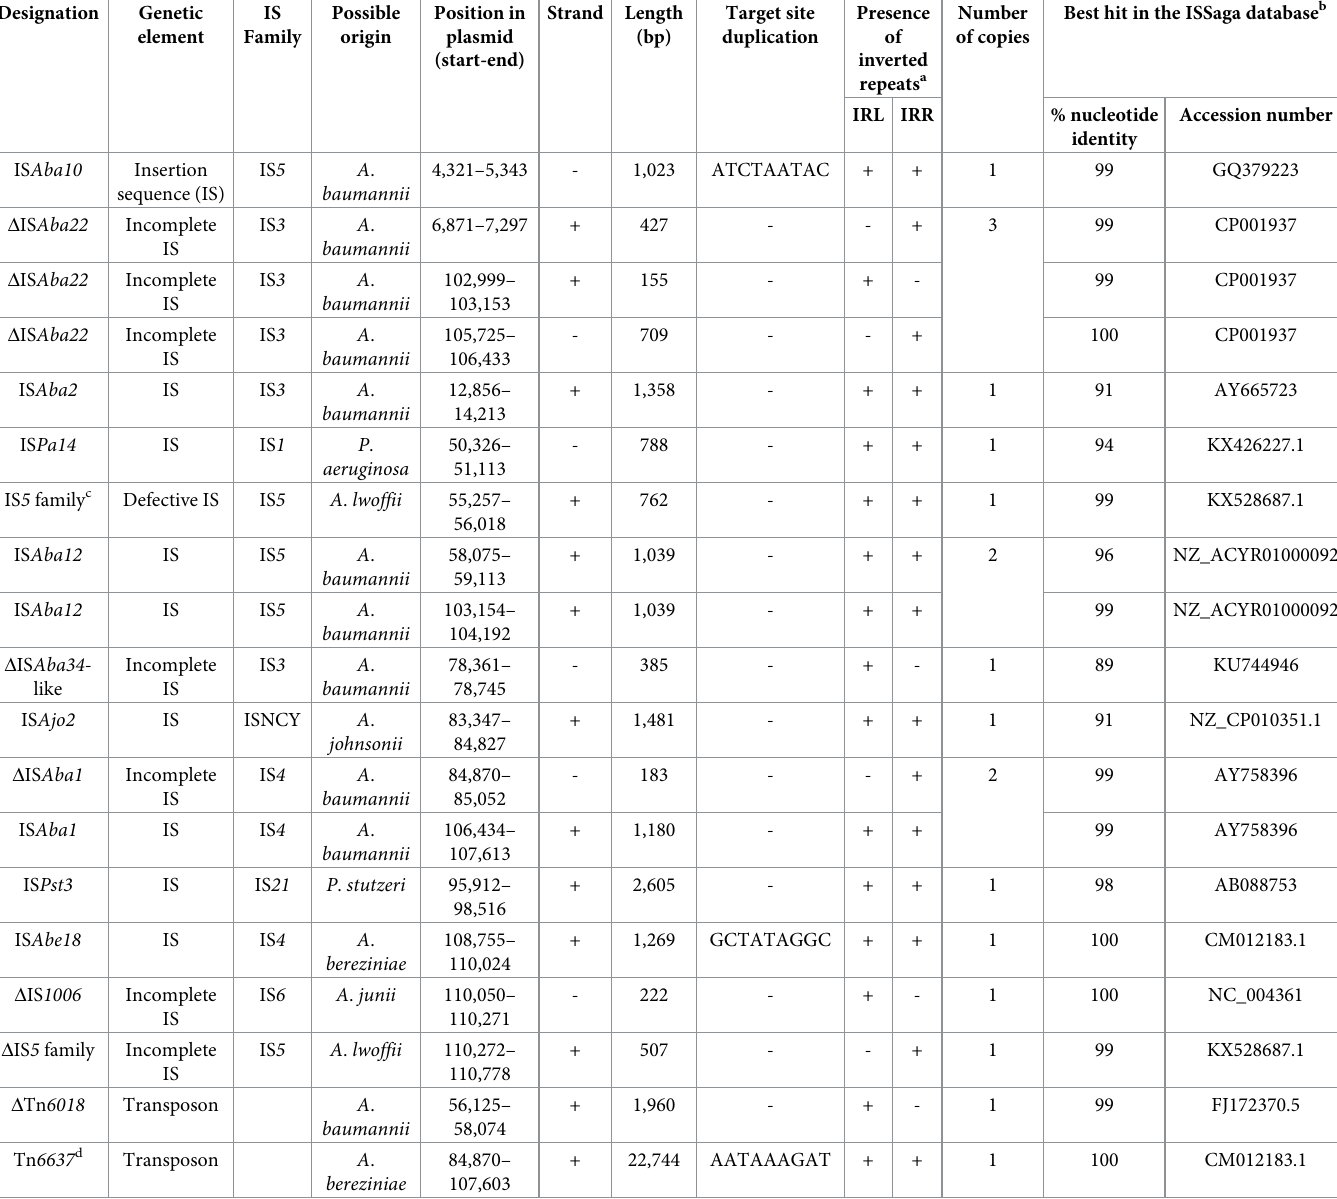
Table 3. Mobile genetic elements detected in